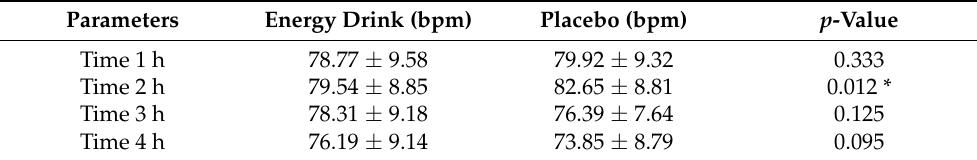
Table 2. The separate effect of beverage on mean heart rate ( n = 26).